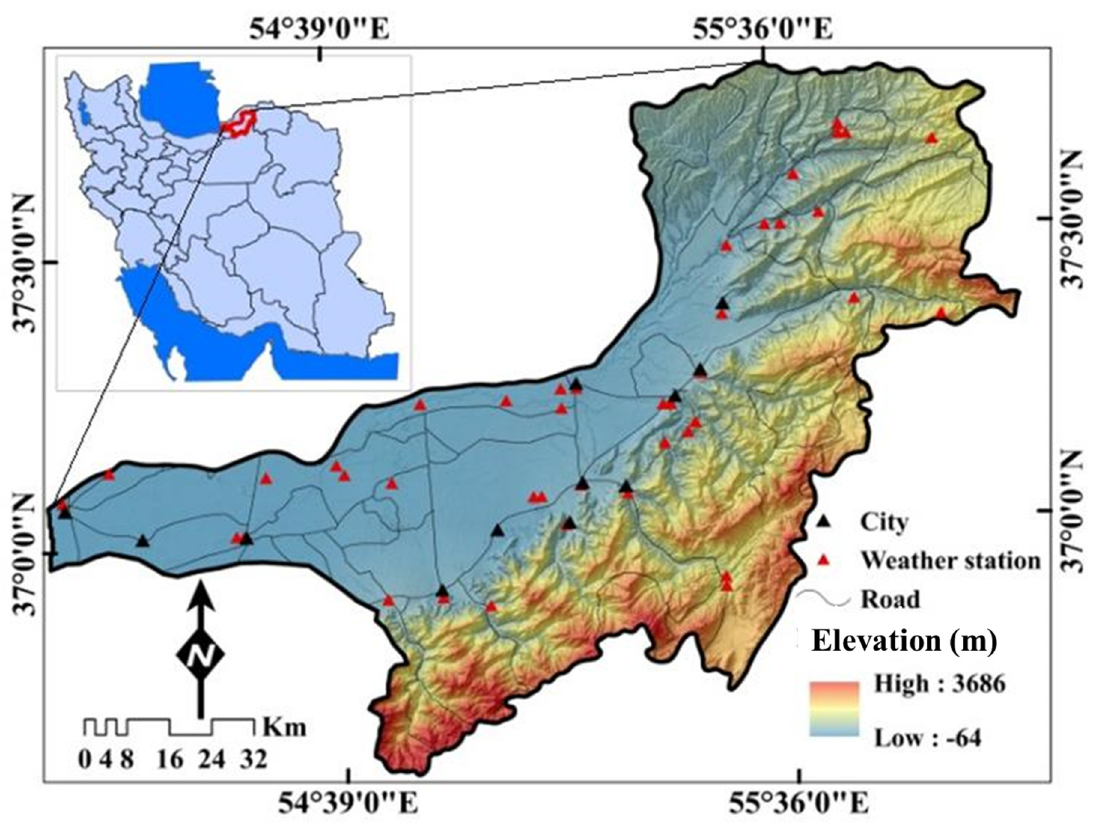
Figure 1. Location of the study area in Iran.